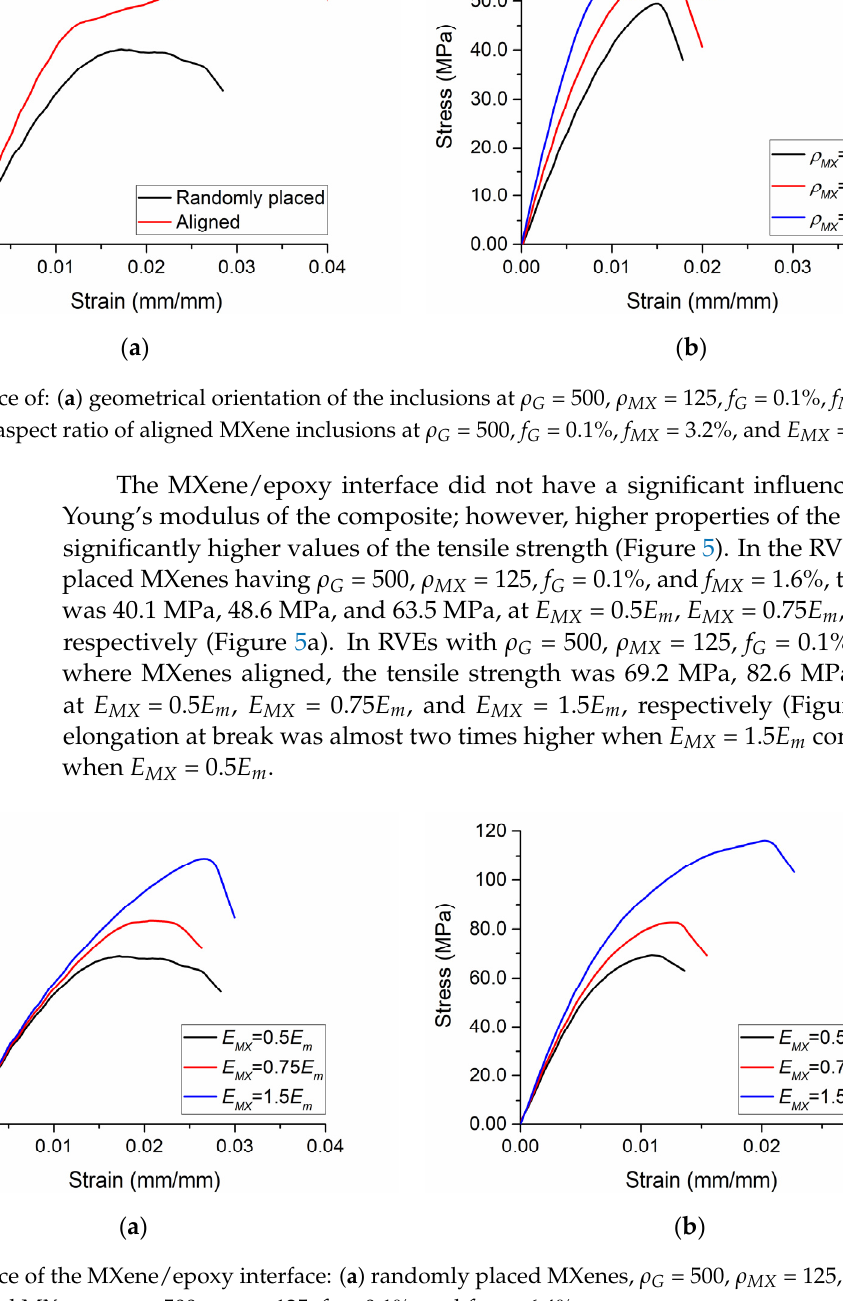
Figure 5. The influence of the MXene/epoxy interface: ( a ) randomly placed MXenes, ρ G = 500, ρ MX = 125, f G = 0.1%, and f MX = 1.6%; ( b ) aligned MXenes, ρ G = 500, ρ MX = 125, f G = 0.1%, and f MX = 6.4%.